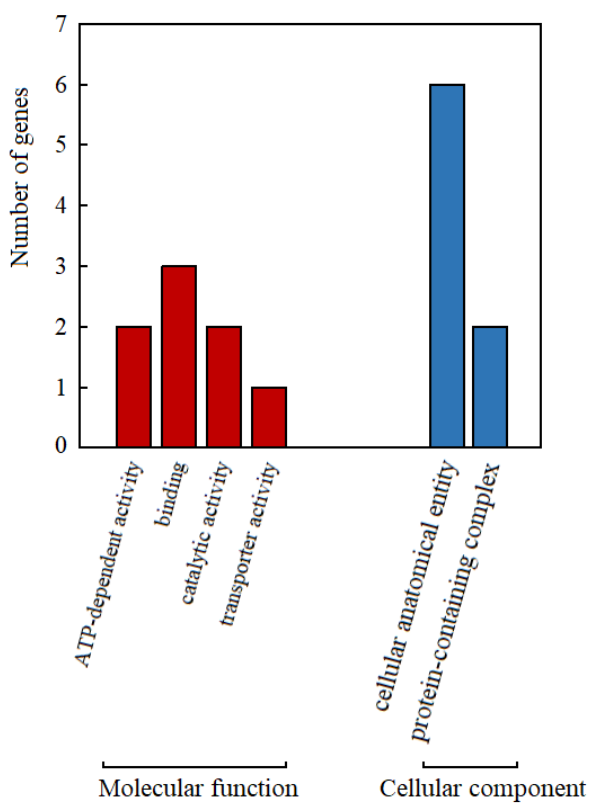
Figure 3. GO function annotation distribution diagram of genes within 50 kb upstream and down- stream of TGS0892 in tomato.